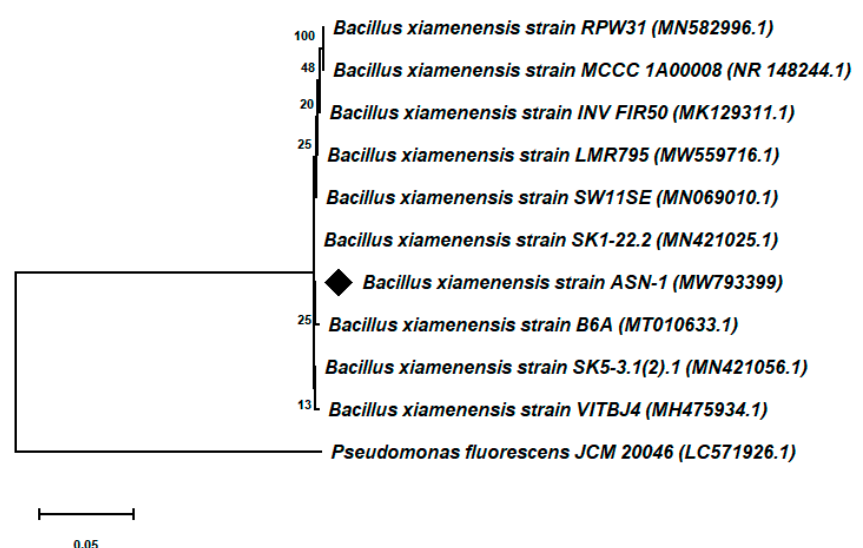
Figure 3. Phylogenetic neighbor-joining dendrogram on the basis of 16S rRNA sequences presenting relationships between the Bacillus xiamenensis strain ASN-1 and related taxa. Pseudomonas fluorescens JCM20046 was used as an out group.